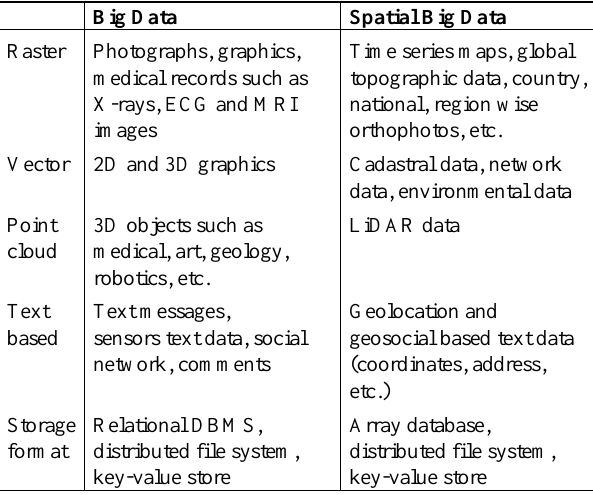
Table 1. Comparison of Big Data and Spatial Big